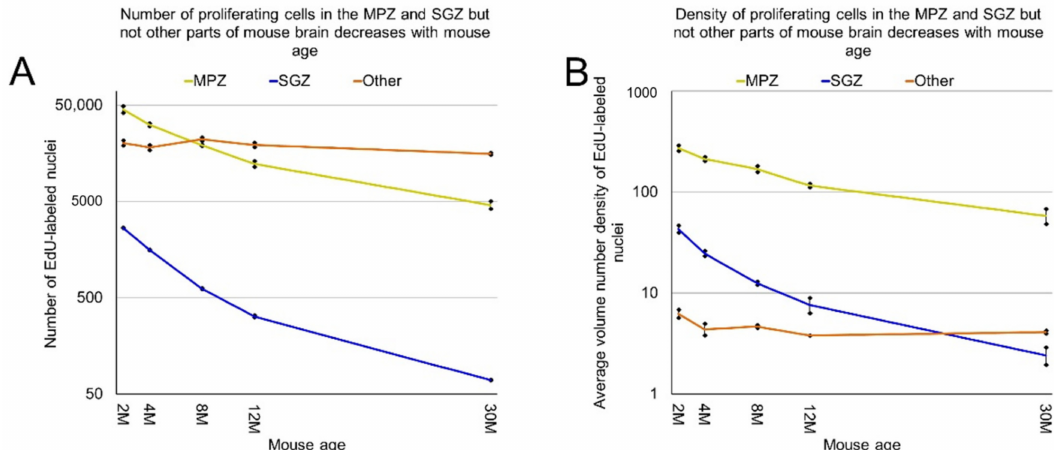
Figure 5. The number and density of proliferating cells in the MPZ, SGZ but not other parts of the mouse brain decrease with mouse age. ( A ) The number of proliferating cells in the MPZ, SGZ, and other parts of the mouse brain changes with mouse age. Error bars show standard deviation; ( B ) the average volume number density of proliferating cells in the MPZ, SGZ, and other parts of the mouse brain changes with mouse age. Error bars show standard